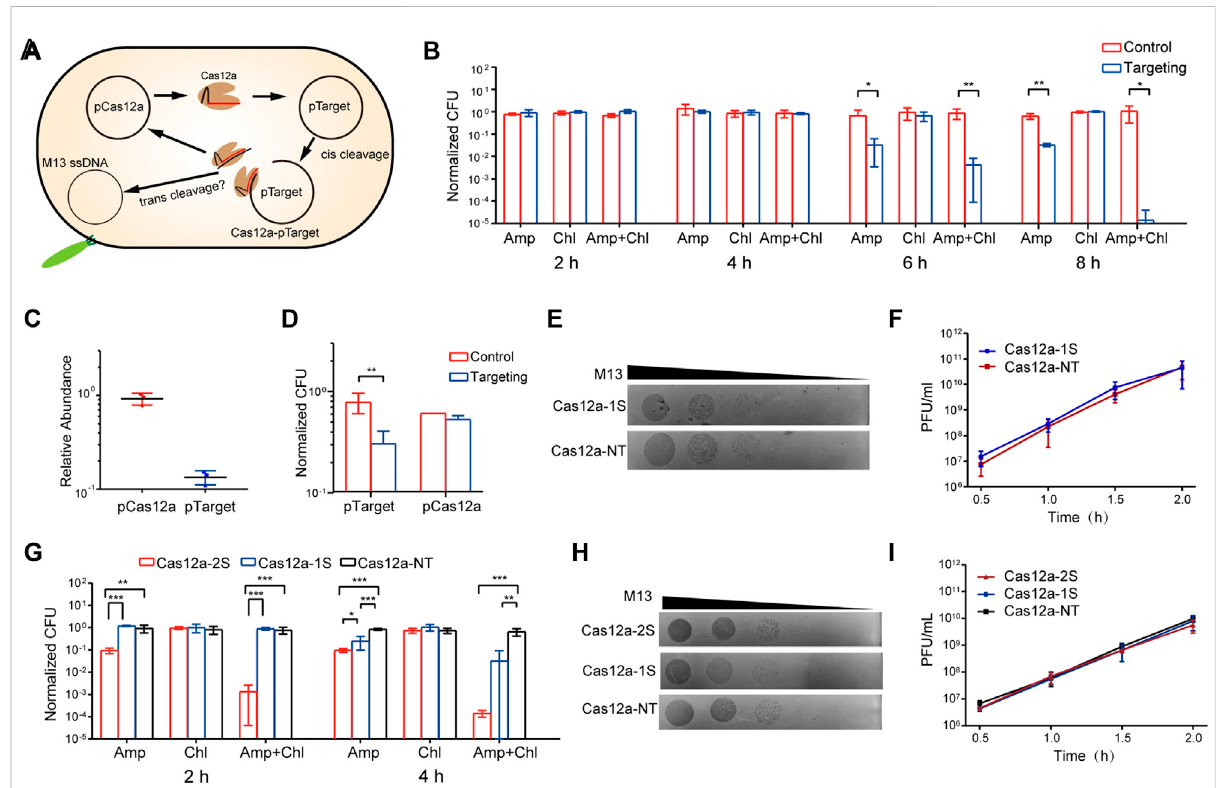
FIGURE 1 Cas12a trans activity does not provide immunity against plasmid or phage (A) An illustration of the design of the study. The pCas12a plasmid expressesCas12acomplex,whichisdirectedbycrRNAtocleavepTarget.ThecleavagegeneratesCas12a-crRNA-targetDNAcomplex,theeffectsof which on pCas12a or M13 phage are analyzed (B) Plasmid maintenance of pTarget (Amp-resistant) and p TS Cas12a-1S (Chl-resistant) after initiating Cas12a targeting. Normalized CFU was calculated using the CFU on the antibiotics-free plates as reference (C) qPCR analysis of the relative abundanceofpTargetandp TS Cas12a-1SafterinitiatingCas12atargeting (D) PlasmidmaintenanceofpTargetandp TS Cas12a-1SafterinitiatingCas12a targeting at 37 ° C (E) Plague formation assay of M13. Ten-fold serial dilutions of M13 were dropped onto bacterial lawns containing p TR Cas12a-1S or p TR Cas12a-NT (F) M13 titers after infecting cells containing p TR Cas12a-1S or p TR Cas12a-NT (G) Plasmid maintenance of pTarget (Amp-resistant) and pCas12a plasmids (Chl-resistant) in cells containing p TR Cas12a-2S, p TR Cas12a-1S and p TR Cas12a-NT respectively (H) Plague formation assay of M13. Ten-fold serial dilutions of M13 were dropped onto bacterial lawns containing p TR Cas12a-2S, p TR Cas12a-1S and p TR Cas12a-NT respectively (I) M13 titers after infecting cells containing p TR Cas12a-1S, p TR Cas12a-1S or p TR Cas12a-NT. All the quanti fi cation data are shown as means of three independent replicates. Error bars indicate the standard deviations. The p -values were calculated by single tail Student ’ s t Test. *: p < 0.05, **: p < 0.01, ***: p <